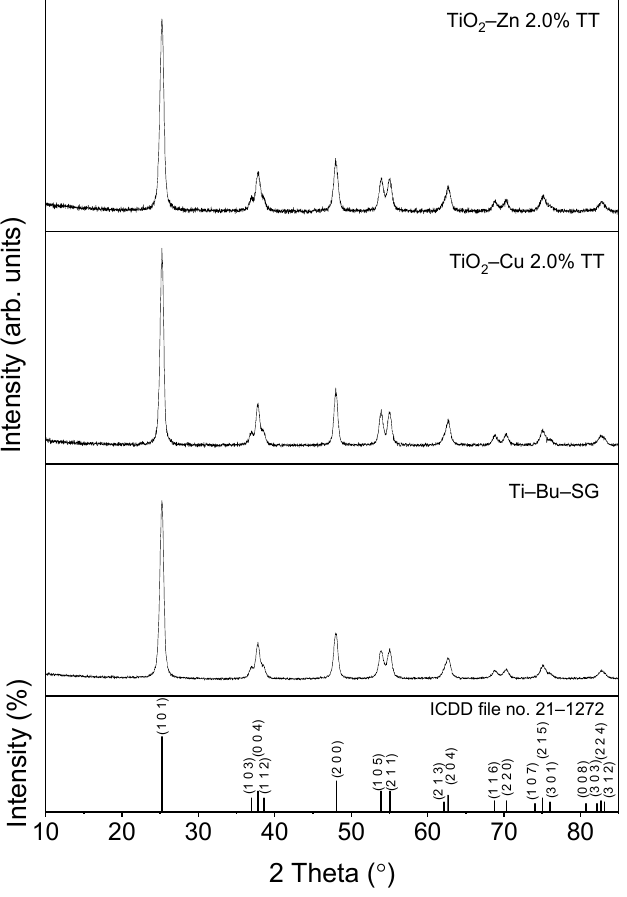
Figure 9. X − ray patterns for powders thermally treated at 500 ◦ C 1 h. Table 2. The lattice parameters and the mean crystalline domain sizes (Dm) of the